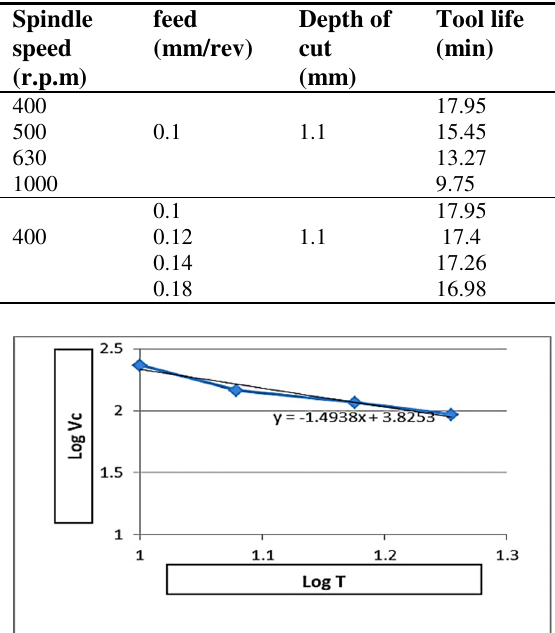
Cutting parameters and experimental results of tool life.